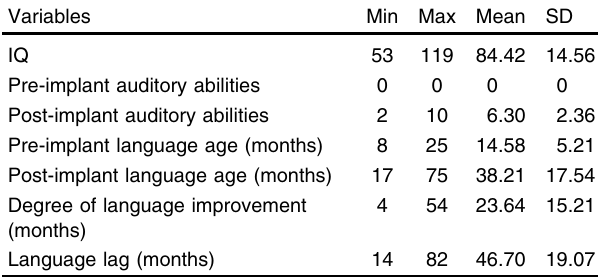
Table 3 Description of the results of the assessment protocol of the studied children (N =